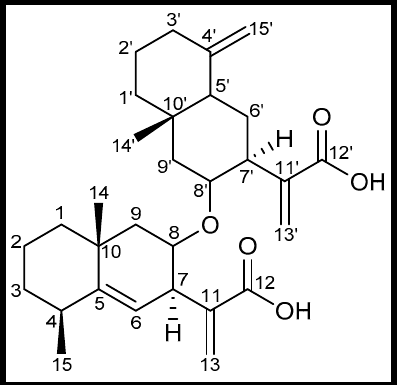
Figure 1. Chemical structure of compound 1